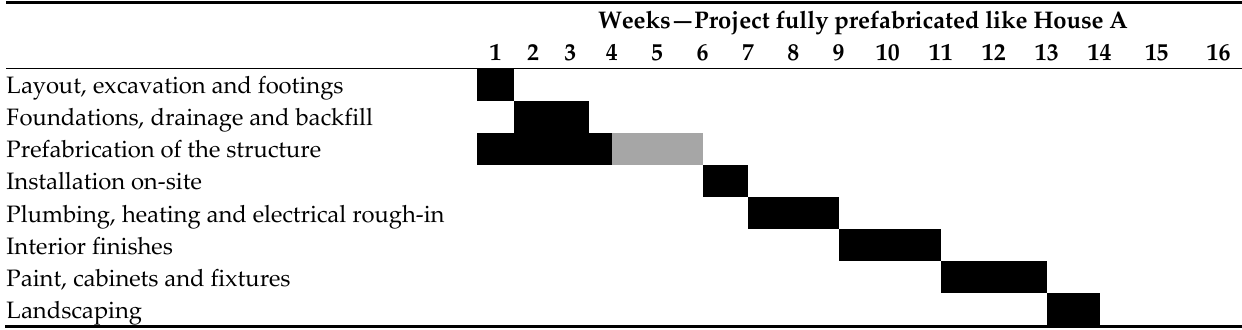
Figure 17. Projection of a schedule for a fully prefabricated house like House A.